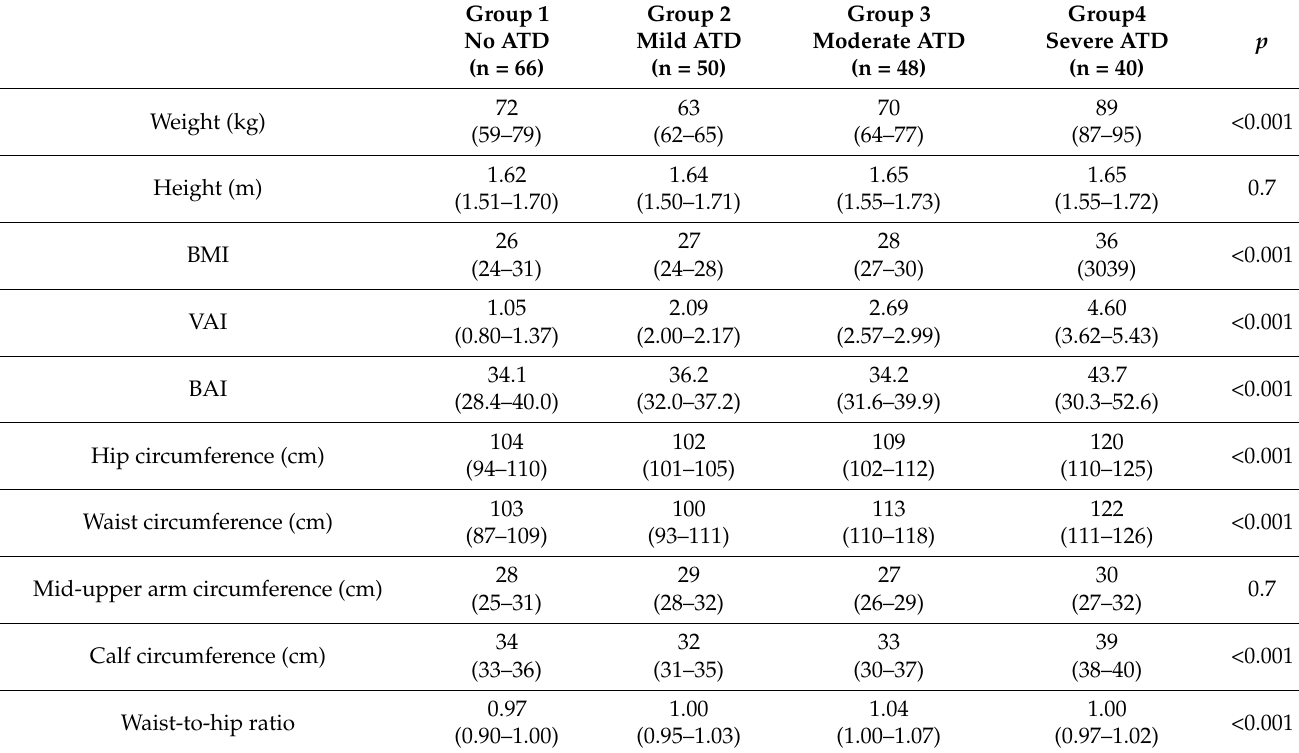
Table 4. Anthropometric and body composition